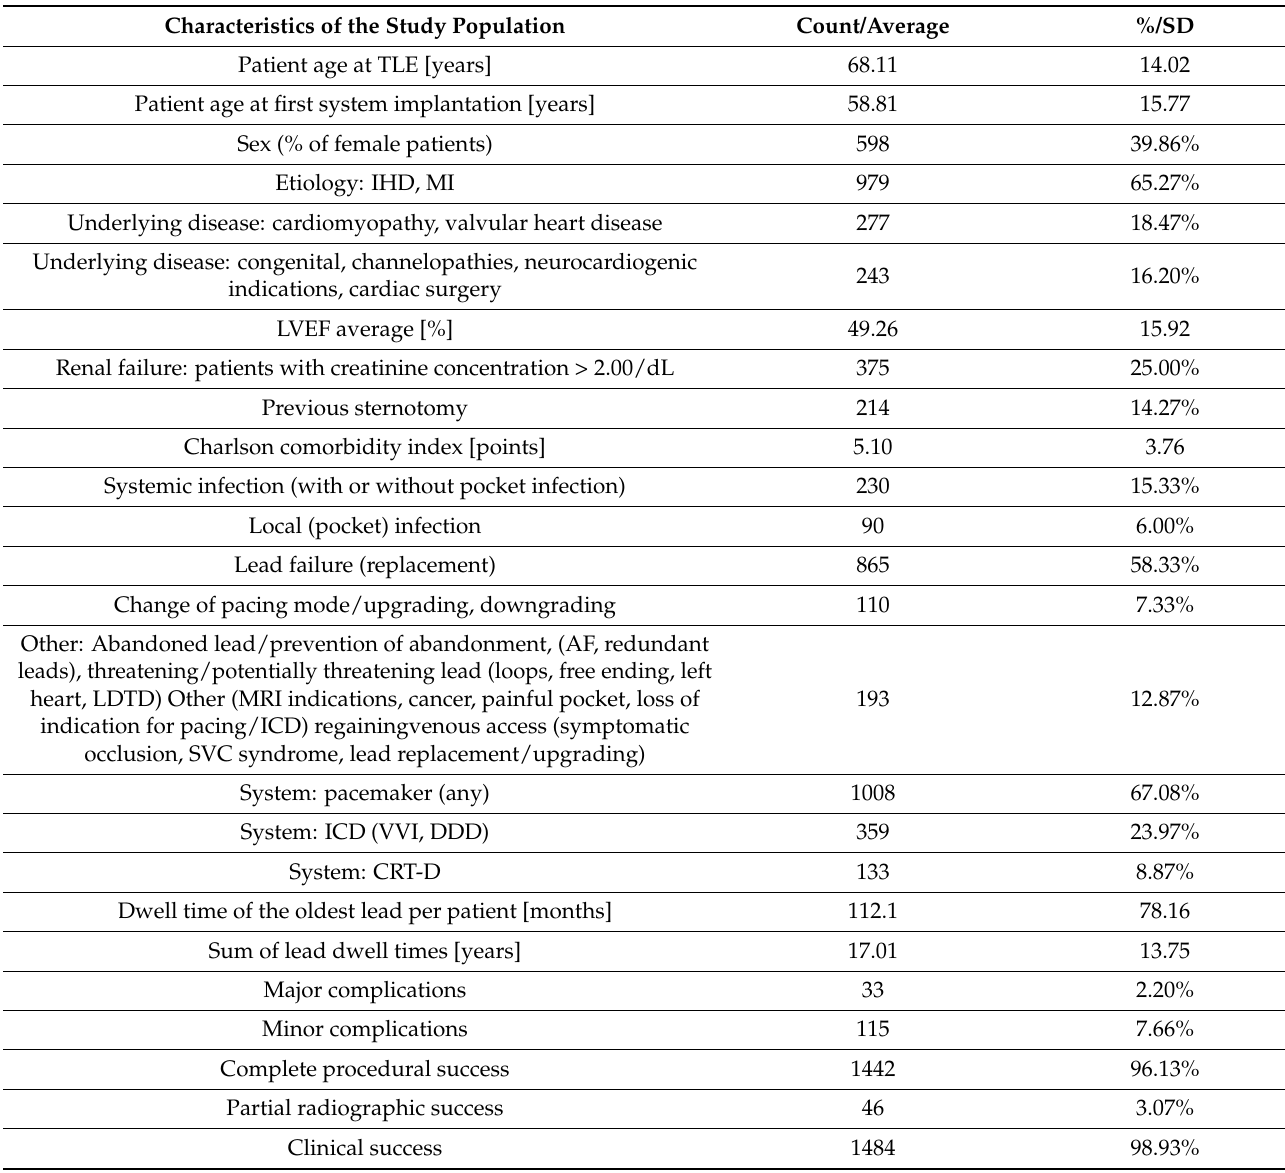
Table 1. Clinical characteristics of the study